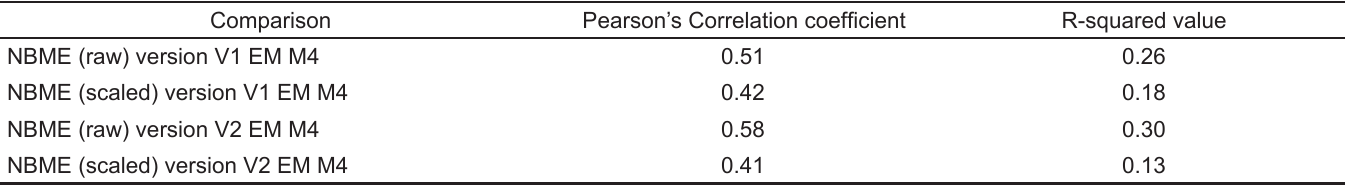
Table 1. Pearson’s correlation coefficient and R-squared values for the NBME EM-ACE (raw and scaled scores) and V1 and V2 of the EM M4